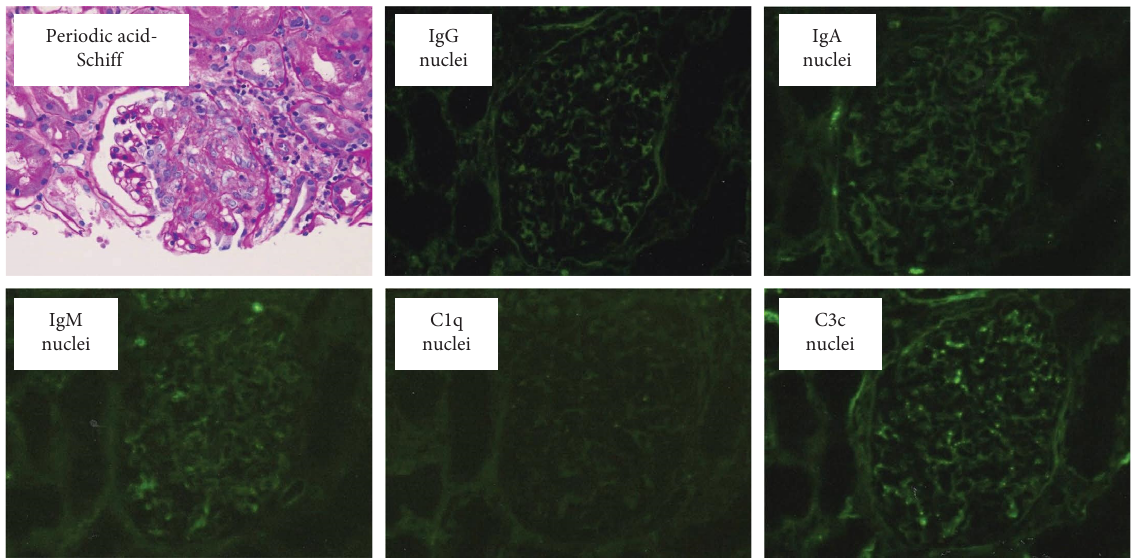
Figure 2: Histopathological fndings in a kidney biopsy confrming pauci-immune crescentic glomerulonephritis. Periodic acid-Schif stain showing a glomerulus with a cellular crescent arising in Bowman’s space (original magnifcation, × 40). Immunofuorescence microscopy fndings of a kidney biopsy. No signifcant deposits of immunoglobulins or complement components were found (original magnifcation, × 40).